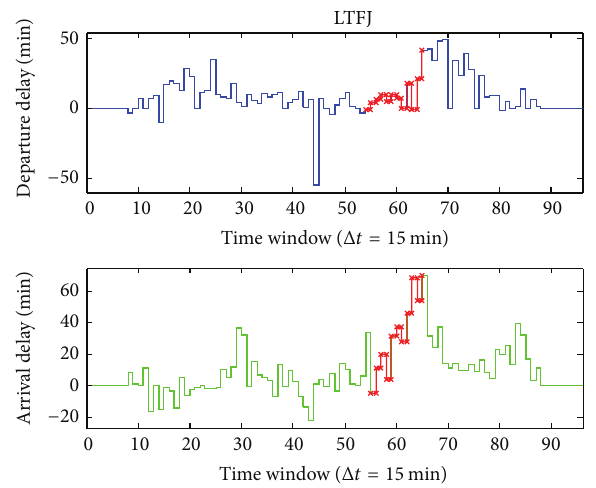
Figure 6: Actual delay profile of LTFJ on June 02, 2015.